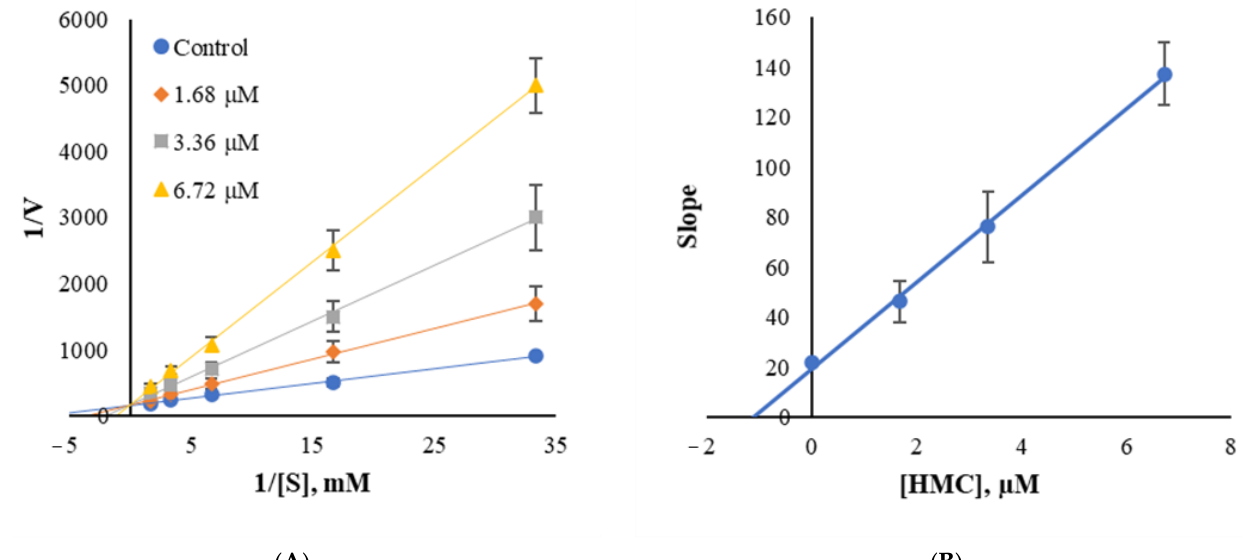
Figure 4. Lineweaver–Burk plots ( A ) and the secondary plot ( B ) of HMC for MAO-B.